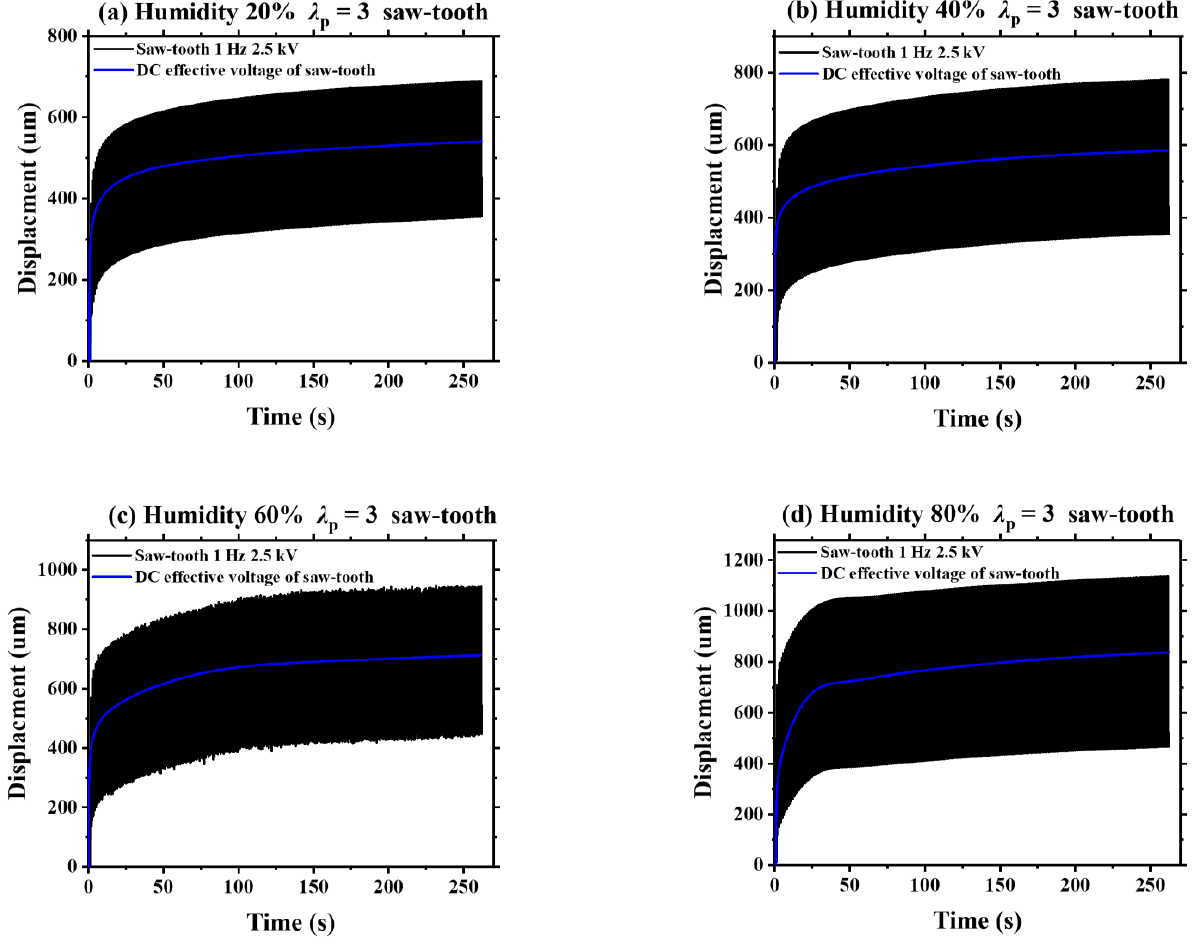
Figure 10. Comparison of the displacements between the effective DC signal and the saw-tooth signal under different ambient humidities.